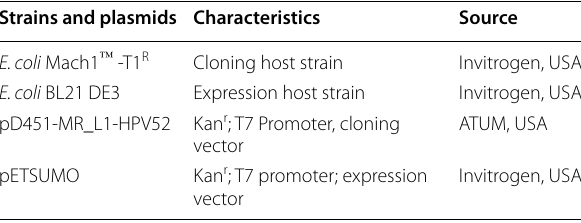
Kan r , kanamycin